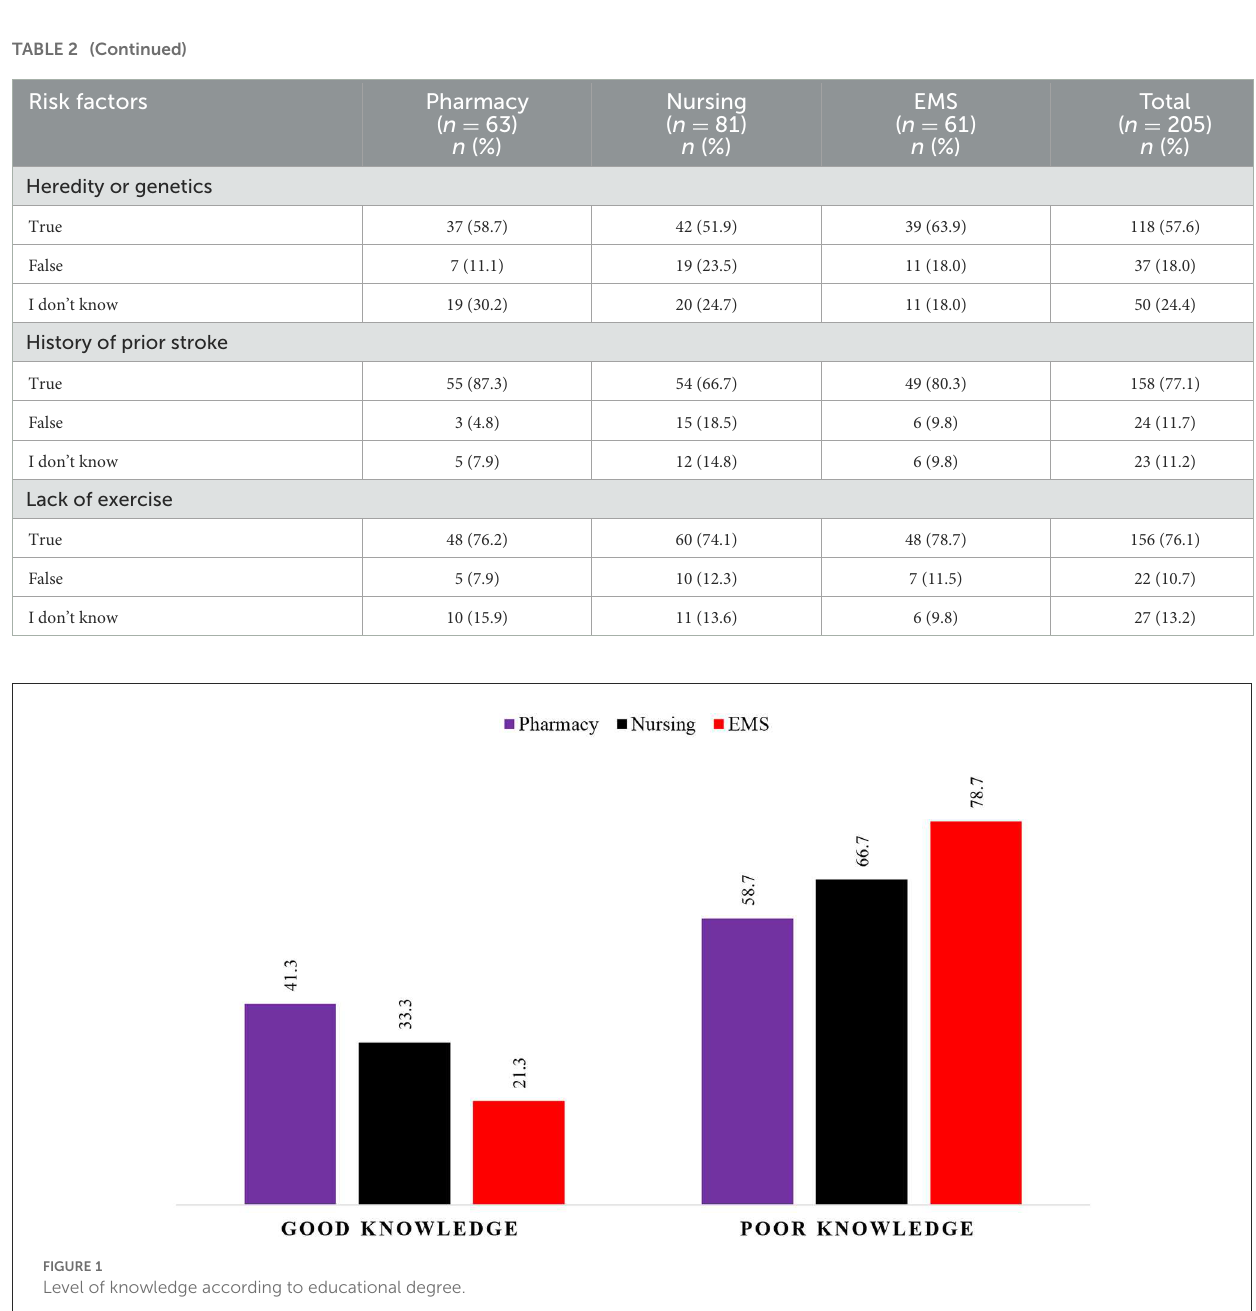
Regarding the warning sign of stroke, the majority of the respondents 164 (80%) identified difficulty in speaking and understanding or slurred speech, while 163 (79.5%) identified dizziness and loss of balance. On the other hand, 159 (77.6%) students, followed by chest pain or heart palpitations and difficulty in walking respectively, reported blurred vision. Focusing only on one of the highest warning signs of stroke, when students were compared on that basis, pharmacy students represented the highest proportion of 85.7%, while others were EMS and Nursing (80.3 and 75.3%) (Table 3). Additionally, when the same approach was used concerning the loss of balance, pharmacy, dental, and medical students’ results were comparable, whereas nursing students had the lowest proportion of 72.8%. While 86.9% of EMS students had a higher proportion of